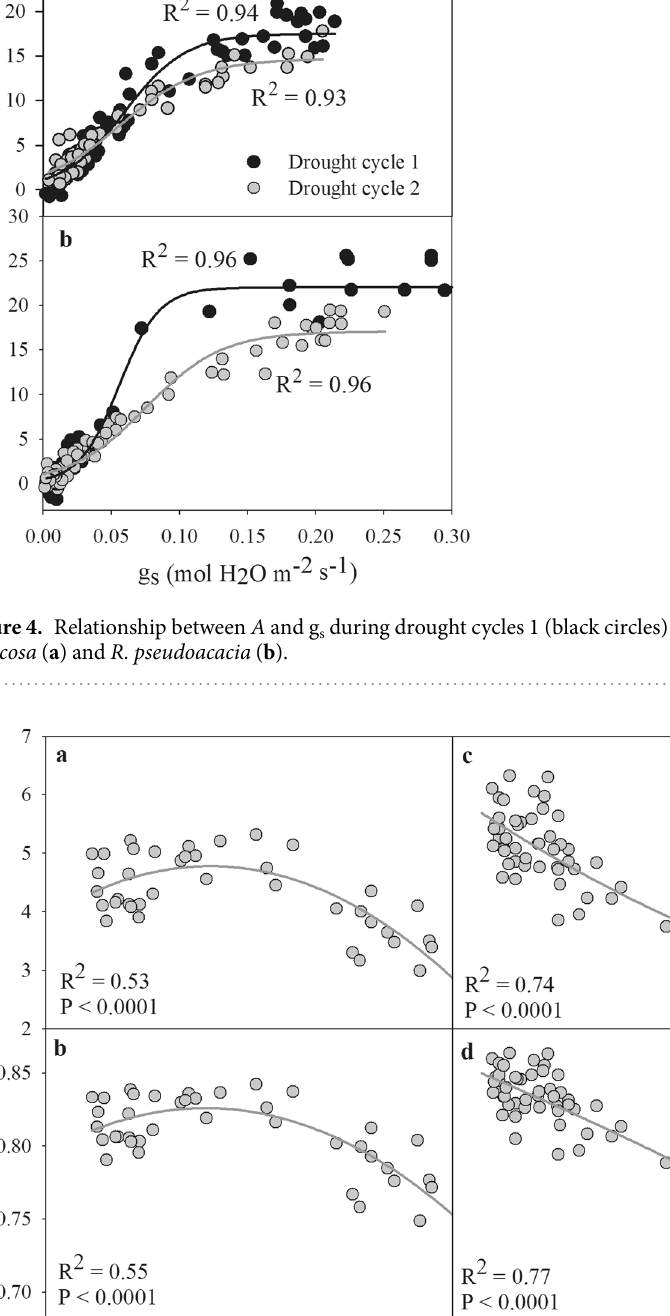
widely in the Loess Plateau region. During both drought cycles, Ψ p declined in both species in parallel with gas exchange due to the course of soil water depletion, which is typical of plants’ responses to drought 28, 30 . In both species, gas exchange parameters were more sensitive than Ψ p to a decrease of the soil water content (Fig. 1).